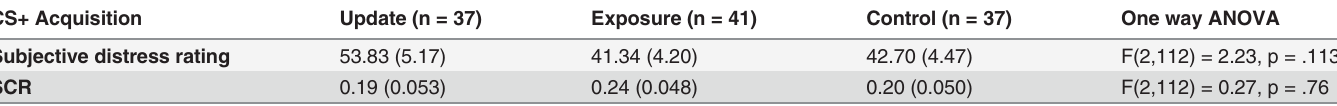
Table 2. Subjective distress ratings and SCR to CS+ following acquisition (means and bootstrapped standard errors). CS+